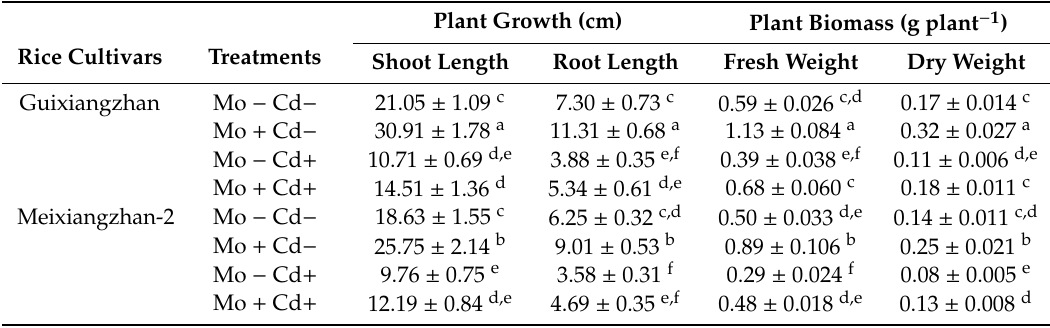
Table 2. Influence of molybdenum (Mo) supply on plant growth and biomass accumulation of fragrant rice seedlings exposed to di ff erent cadmium (Cd)